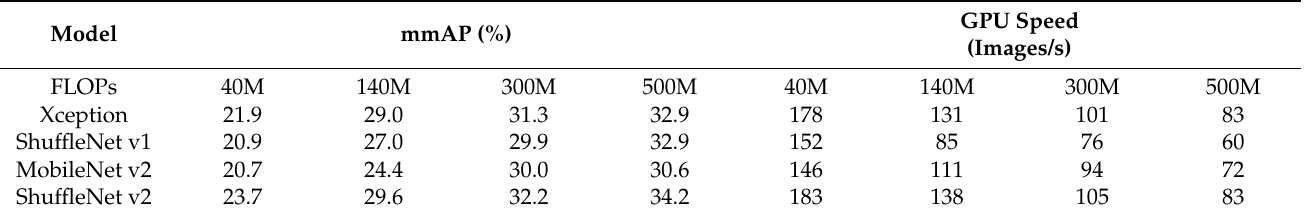
Table 1. Measurement of accuracy and GPU speed of four different lightweight models with the same level of FLOPs on COCO object detection. (FLOPs: float-point